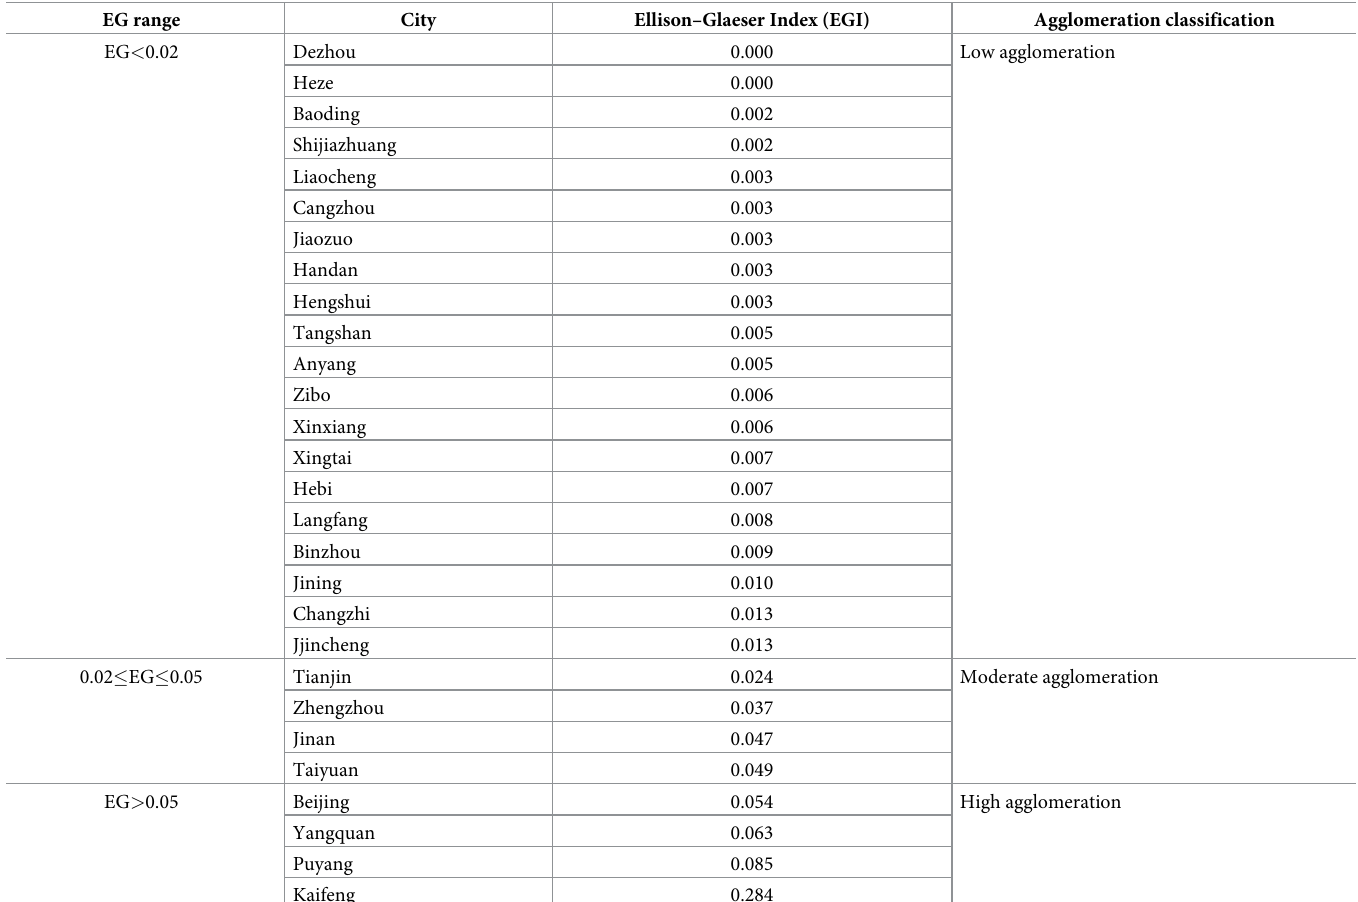
Table 3. EG Index in BTH and the surrounding “2+26”